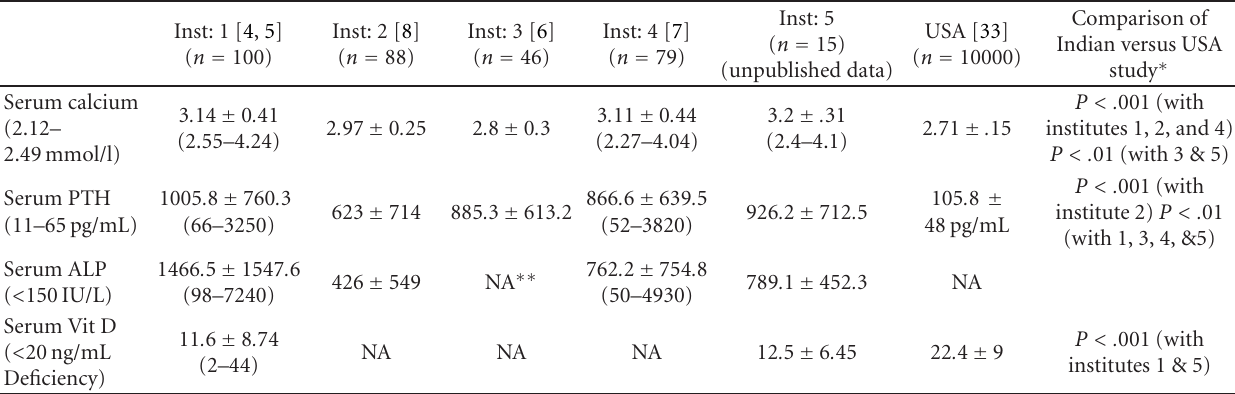
Figure 4: Advanced bone disease (OFC) excised and replaced with humerus prosthesis in a patient with PHPT where the diagnosis was missed. Table 2: Comparison of biochemical profile in PHPT from various Indian institutes and a center in